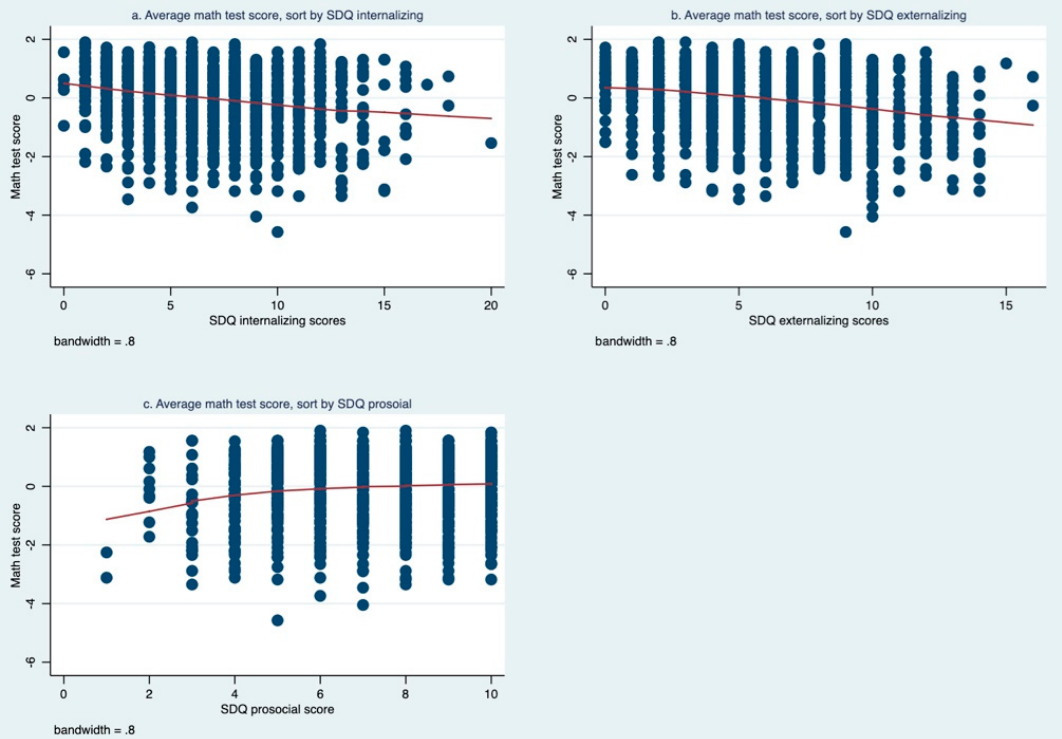
Figure 1. Mean of math test score by SDQ internalizing, externalizing, and prosocial scores: ( a ) average math test score sorted by SDQ internalizing; ( b ) average math test score sorted by SDQ externalizing; ( c ) average math test score sorted by SDQ prosocial. Throughout the figures, we deleted extreme values (which accounted for less than 1% of the sample), to better present the trend of changes in the SDQ subscale scores and math test scores.